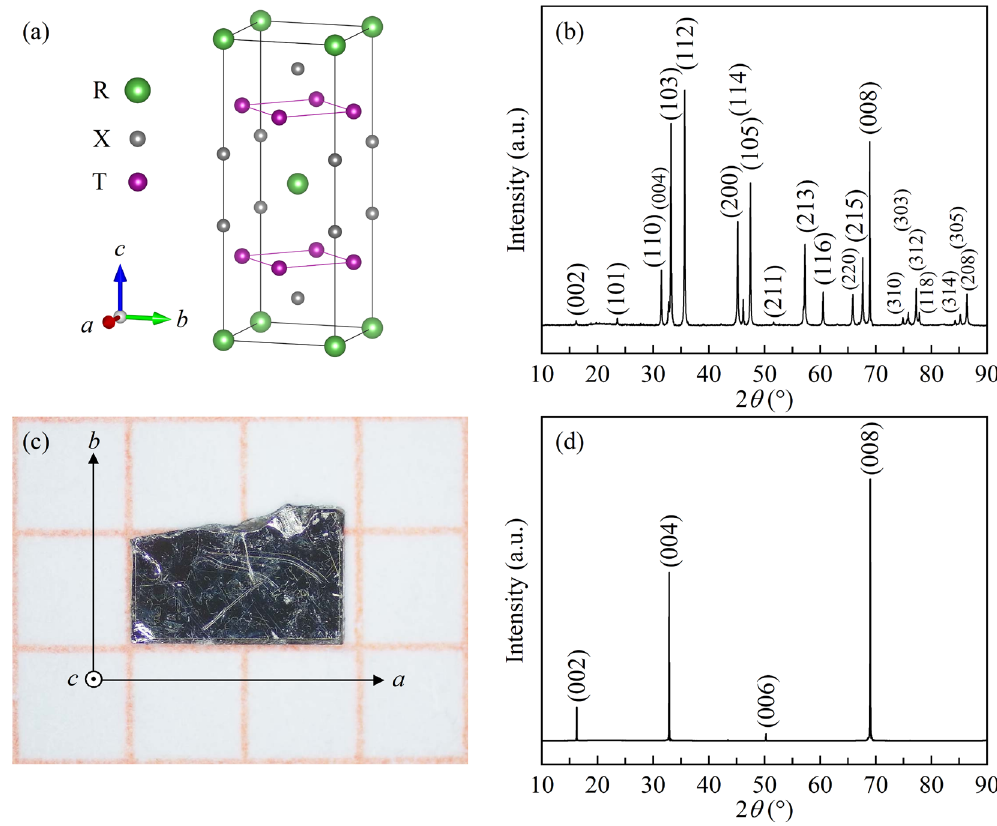
photograph of TbMn 2 Ge 2 single crystal. ( d ) Room-temperature XRD patterns for TbMn 2 Ge 2 single crystal recorded on (00 l )